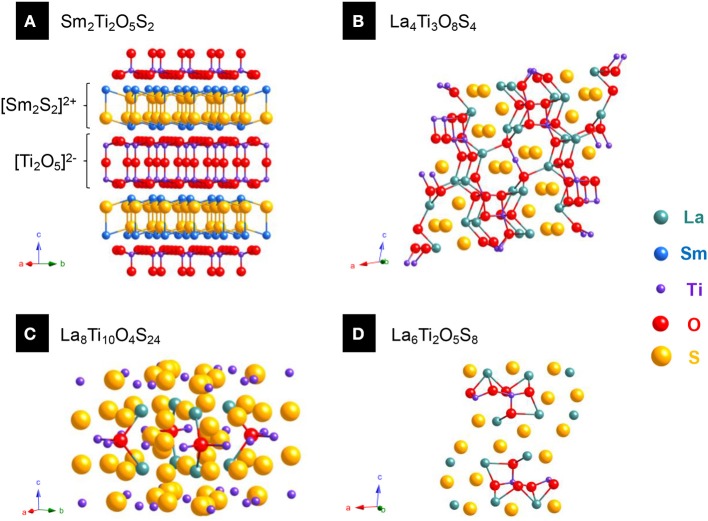
Various quarternary oxysulfide structures containing titanium. (A) Sm2Ti2O5S2 (JCPDS 13-1325) exhibits selective bonding as sulfur is preferentially bound to titanium and oxygen to samarium. (B) La4Ti3O8S4 (JCPDS 09-7018), (C) La8Ti10O4S24 (JCPDS 09-8085), and (D) La6Ti2O5S8 (JCPDS 09-7017) show different structures with unselective bonding.